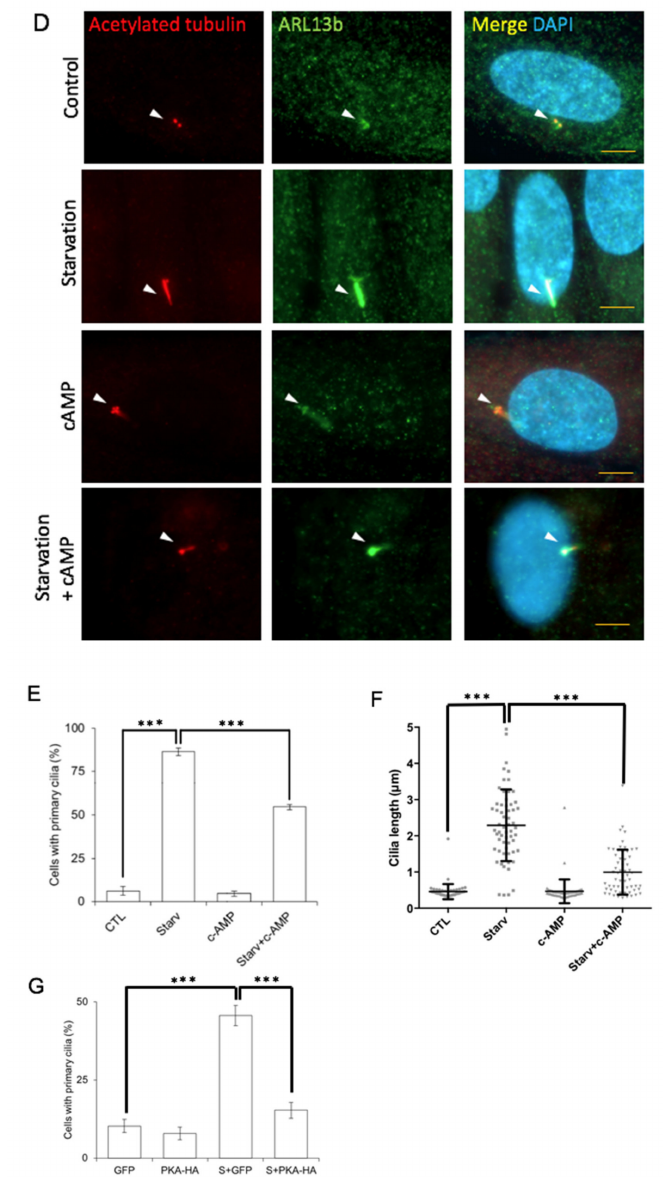
Figure 7. PKA-mediated SEPT7 phosphorylation affects ciliogenesis. ( A , B ) The level of Thr phospho- rylation in 293T or NT2D1 cells was reduced after overexpression of FLAG-SEPT7 in the medium with or without serum for 24 h. Extracts of SEPT7-transfected cells with or without serum were analyzed by immunoblotting with antibodies against FLAG and phosphothreonine. Lanes showing 10% of the input are also present. SEPT7 phosphorylation inhibited primary cilia formation. ( C ) Quantitation of primary cilia in FLAG-SEPT7, FLAG-SEPT7 T197A, or FLAG-SEPT7 T197E-transfected RPE1 cells in the absence of serum. Activation of PKA followed by 8-Br-cAMP inhibited primary cilia formation ( D , E ) and reduced the ciliary length ( F ) under serum starvation. ( D ) Immunostaining of primary cilia and DAPI in scramble control (CTL) or 8-Br-cAMP-treated RPE1 cells. RPE1 cells were analyzed with antibodies against acetylated tubulin (ace-tub, red) and Arl13b (green). Scale bare: 5 µ m. ( E , F ) Treatment with cAMP inhibited primary cilia formation. Quantitation of ciliated cells ( E ) or ciliary length ( F ) upon 8-Br-cAMP-treated RPE1 cells in the presence or absence of serum. ( G ) Overexpression of PKA inhibited primary cilia formation under serum starvation. RPE1 cells were transfected to GFP or HA-PKA in the presence or absence of serum (S). Quantitation of primary cilia of GFP or HA-PKA-transfected RPE1 cells under serum starvation. These results are the mean ± SD from three independent experiments; more than 100 cells were counted in each individual group. Data are shown as mean ± SEM. N.S., nonsignificant; *** p <